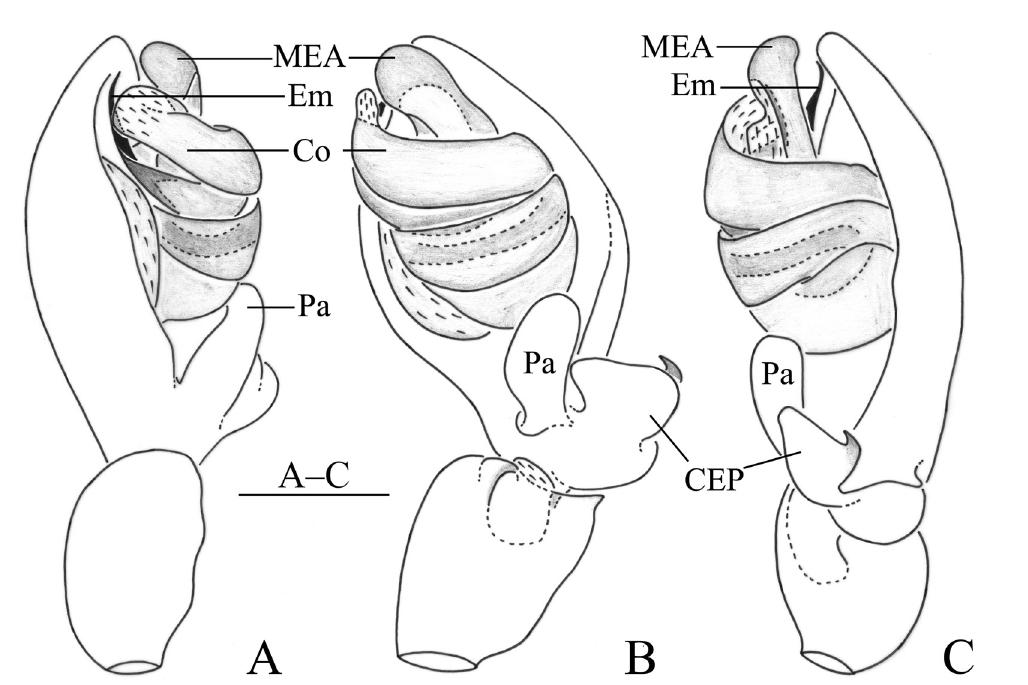
Fig. 6. Meta longlingensis sp. nov. Left palp of holotype ♂ (HNU-Tang031029). A . Prolateral view. B . Ventral view. C . Retrolateral view. Scale bars: 0.2